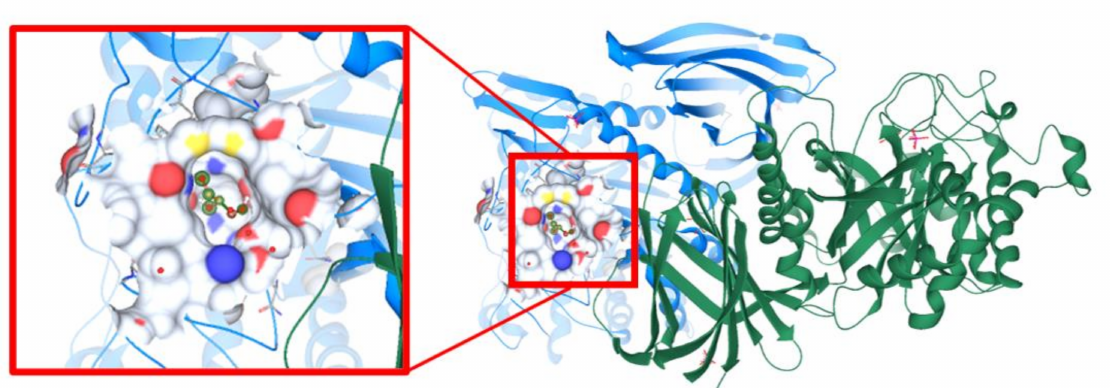
Figure 17. Protein crystal structure of SrfJ from Salmonella typhimurium with PDB ID: 2WNW. Enlarged region represents the binding site of the protein Chain A with cocrystal glycerol.